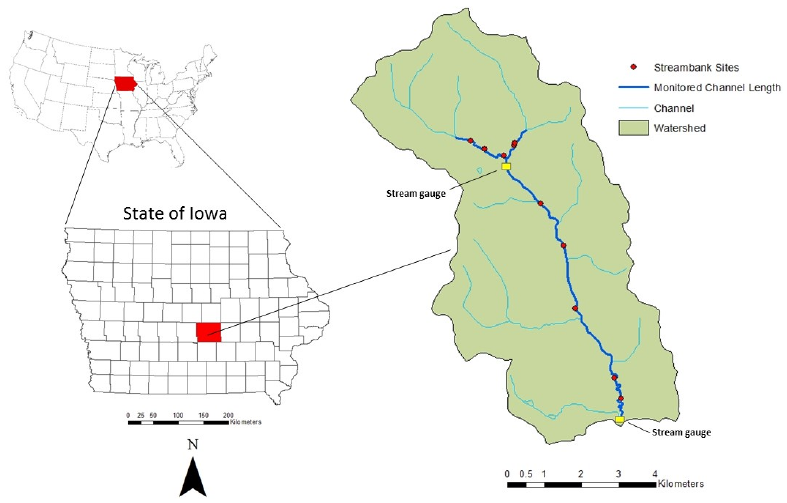
Figure 1. Location of watershed, monitored channel length, and streambank sites, Walnut Creek, Iowa, USA.